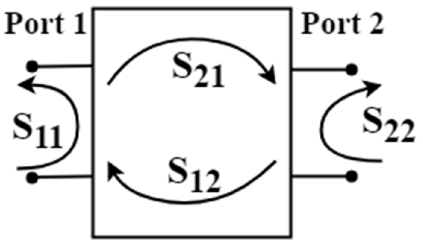
Figure 7. S-parameter in two-port network.